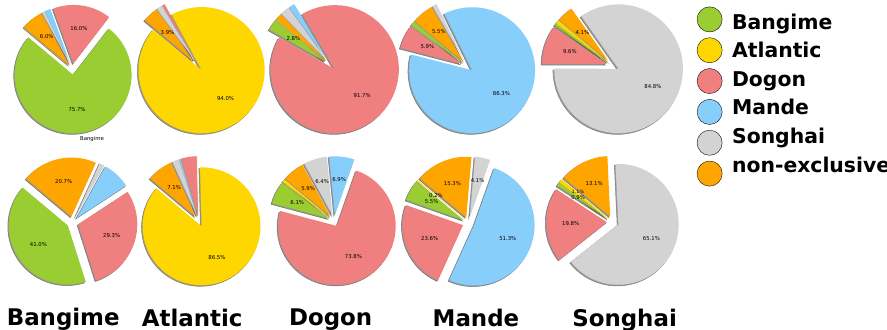
Figure3: Comparingexclusivelysharedcognatesacrosslanguagefamiliesinour sample for LexStat‑Infomap (top row) and SCA (bottom row). The “non‑exclusive” group refers to cases where inferred cognate sets are attested in more than two